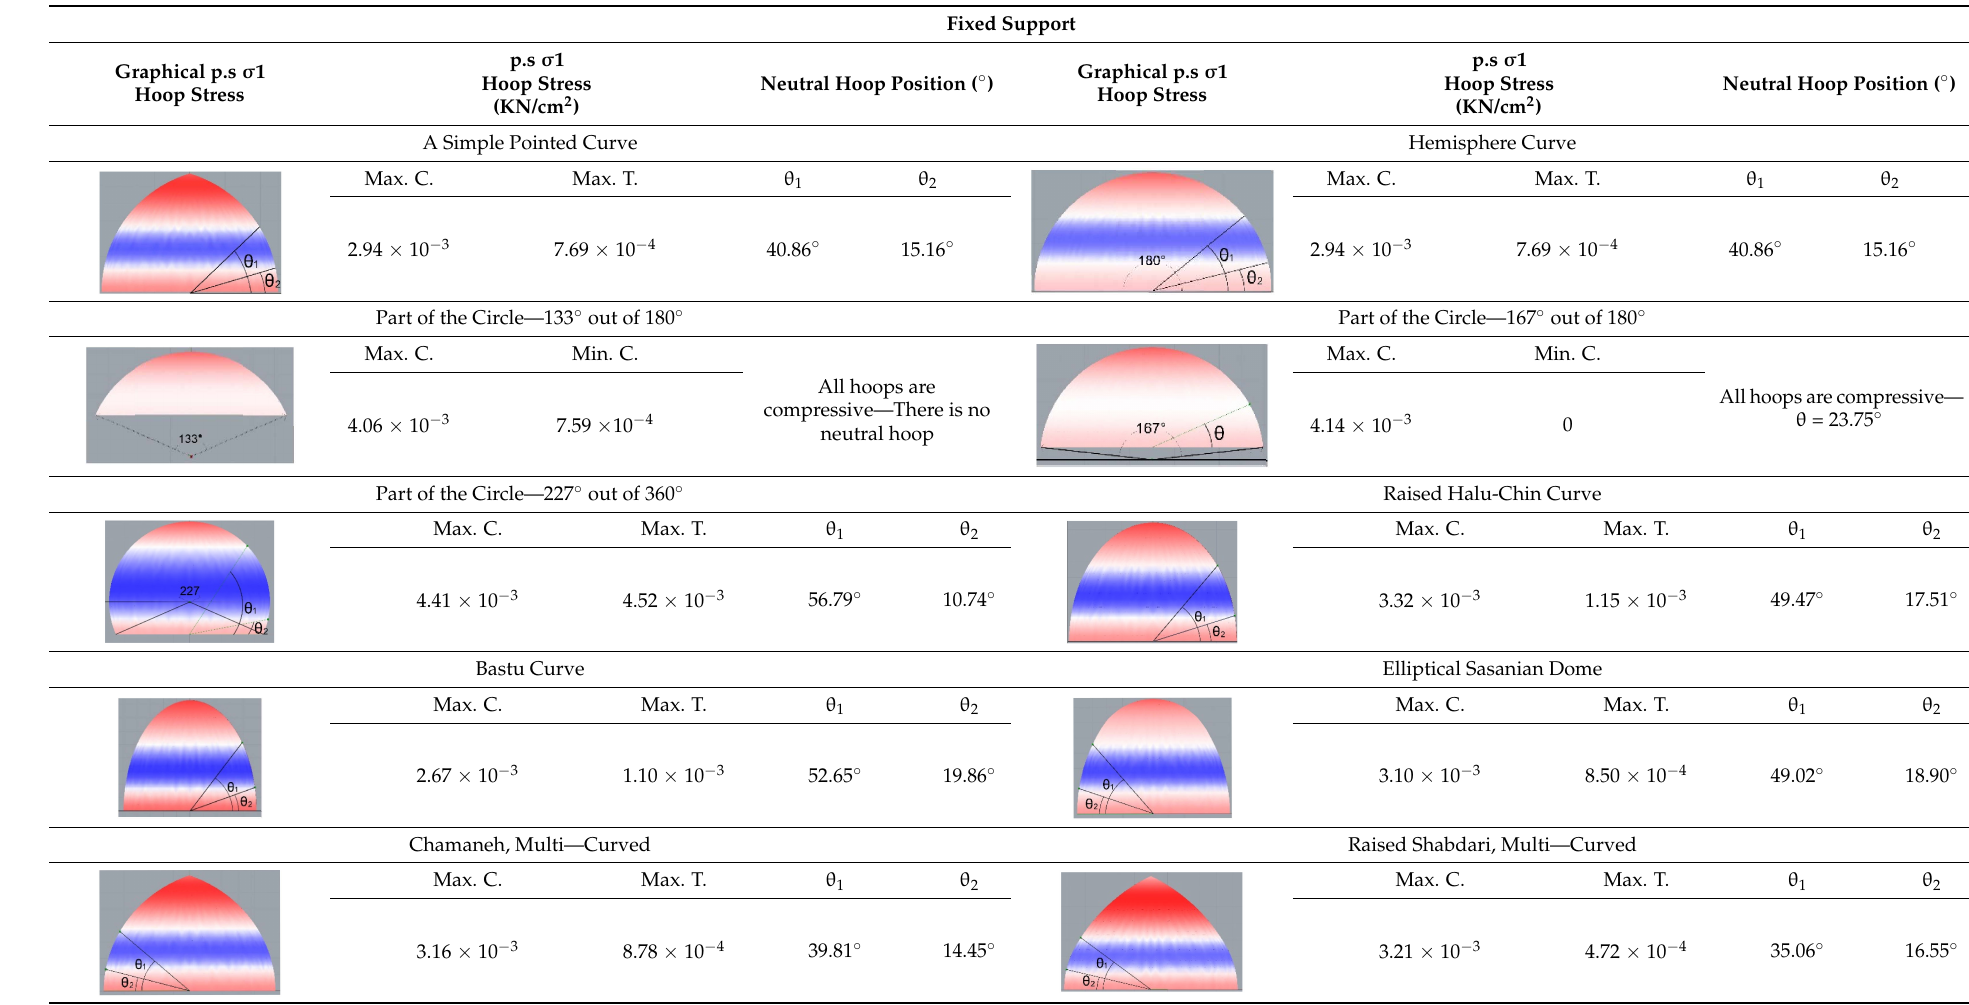
Table 4. Analysis of domes with fixed support—R m = 5 m, t dome = 90 cm, t dome /d m =